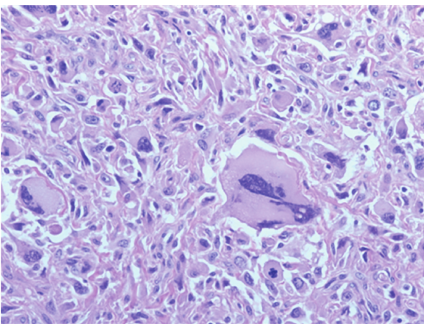
Figure 2: Microscopic view (400x) of the second tumor of the right upper leg. Based on the morphology, clinical history, and immunoprofile it was diagnosed to be a localization of a high grade sarcoma NOS.